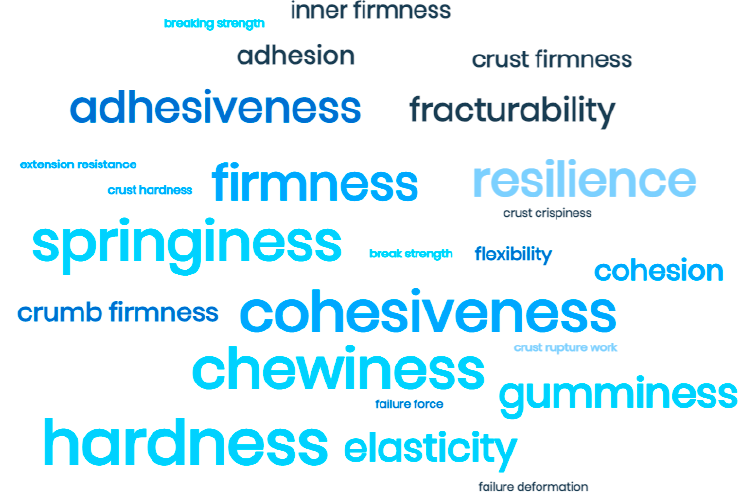
Figure 6. Word cloud for the properties analyzed through instrumental texture analysis in bakery products. ery products.